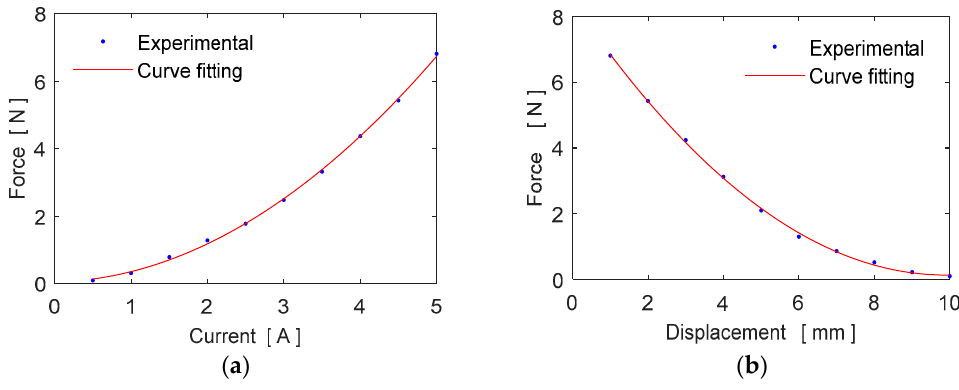
Figure 8. Variation of the electromagnetic force ( a ) with current, ( b ) with displacement.